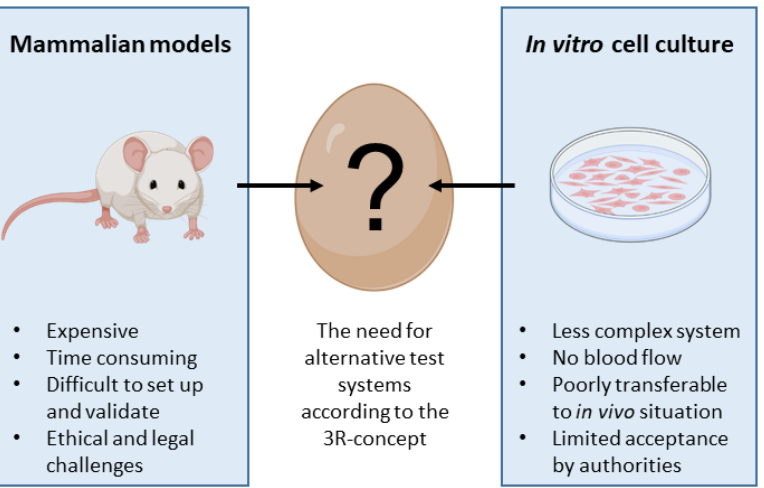
Figure 4. Scheme showing the intermediate position for the CAM model between mammalian mod- els and in vitro cell culture. and in vitro cell